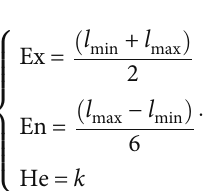
Figure 5: The evaluation fl